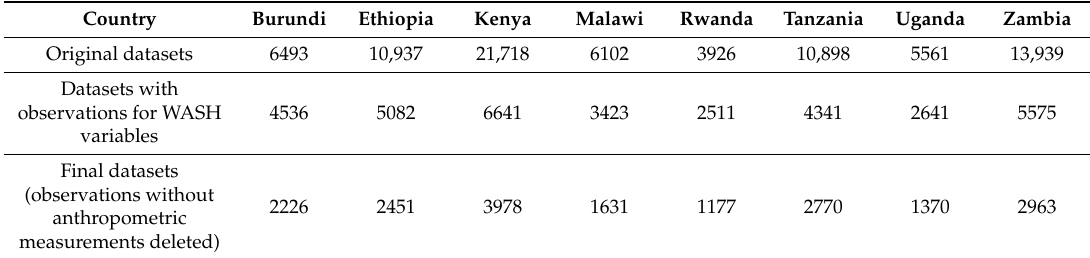
Table 1. Detailed sample size of the households with 6–23 mo children included for the eight East African